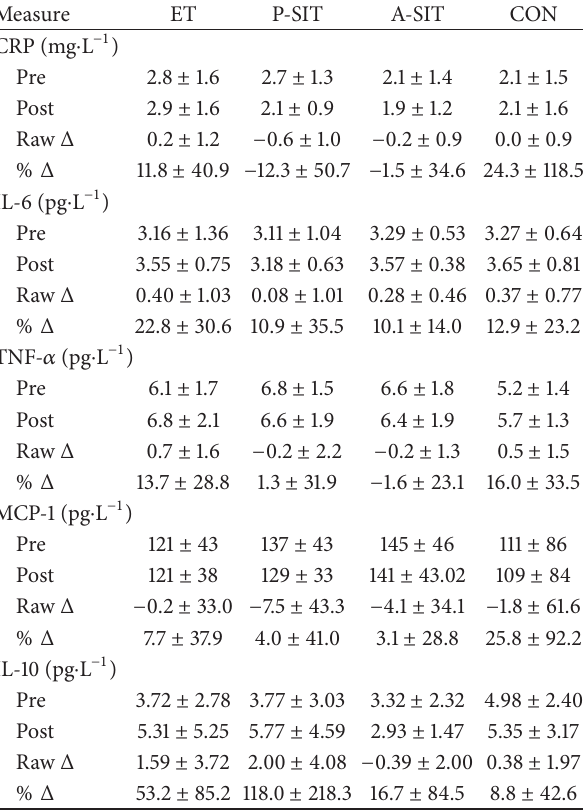
Table 3: Body mass and composition data. Table 4: Measures of plasma systemic